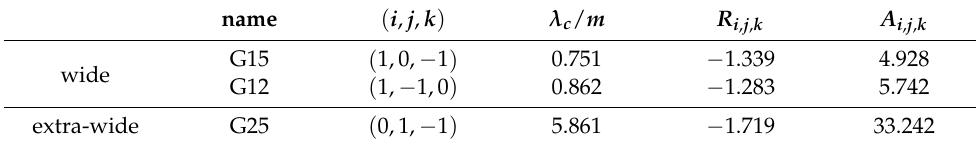
12 of 18 Figure 17. The reference stations of CEBR and VILL. (https://www.epncb.oma.be/_network- data/stationmaps.php, accessed on 1 October 2021). Table 4 lists the optimal extra wide (in bold) and wide-lane combinations of GPS in